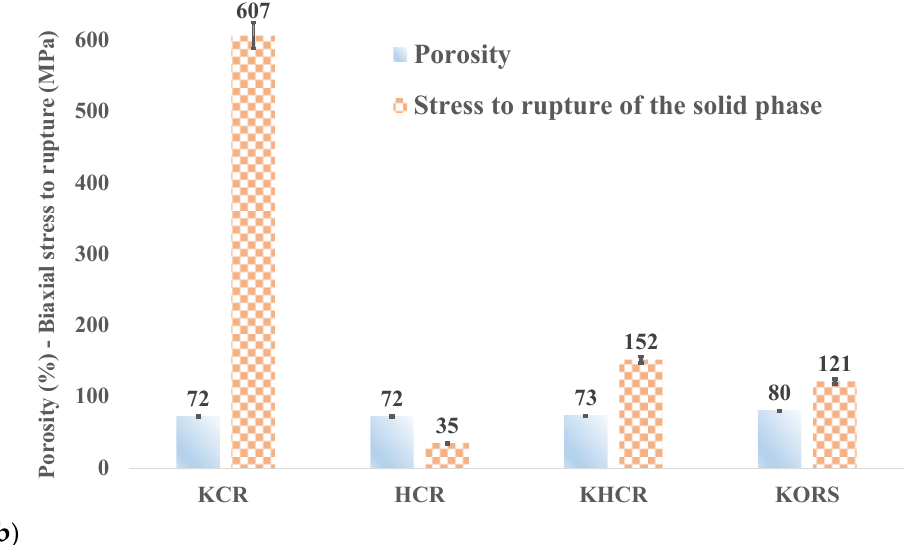
Figure 8. Biaxial flexural strength and porosity of ( a ) manufactured porous ceramics and ( b ) corre- sponding solid-phase stress-to-rupture. Discs sintered at 1200 ℃.